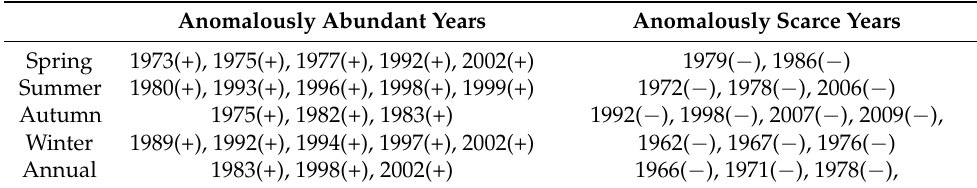
Figure 8. Spatial distribution of the monthly average rainfall in the YRB from 1961 to 2010. Table 2. Abnormal rainfall years in the YRB from 1961 to